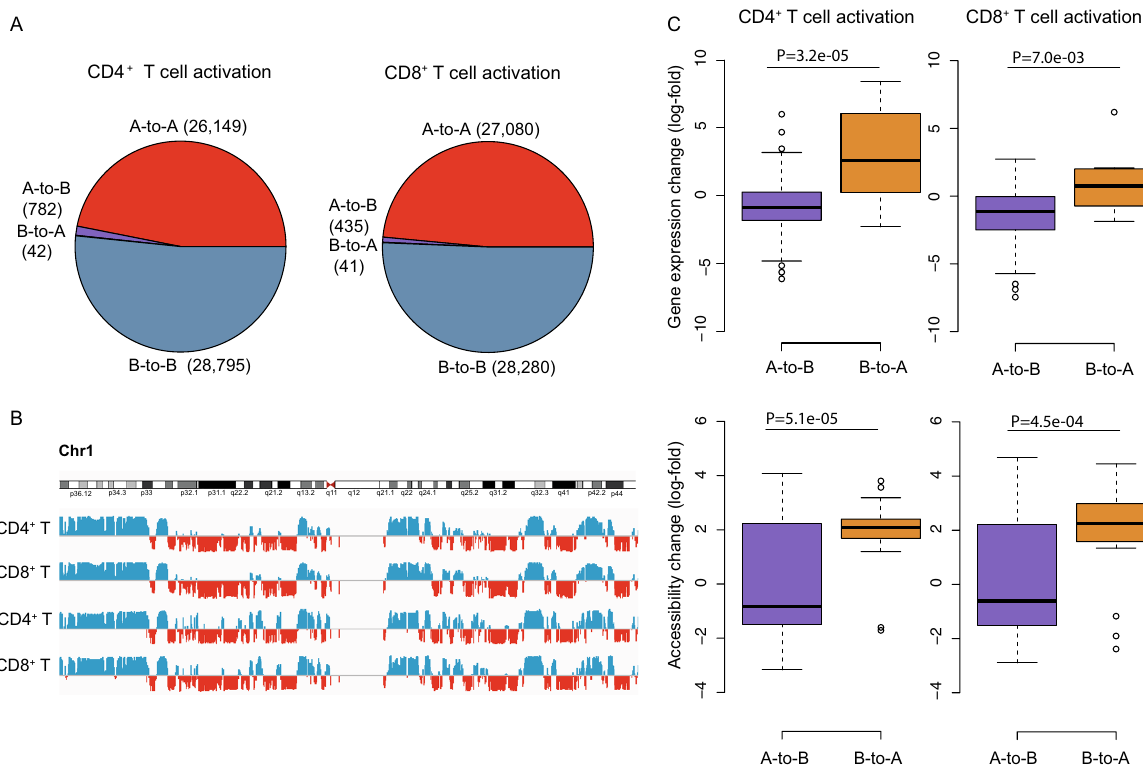
Figure 7. Chromosome A/B compartments are not substantially altered by T cell activation. ( A ) Pie charts showing the distribution of chromatin regions in the four different group of compartment changes: stable (A to A, B to B) or flipping (A to B and B to A). This was defined by pairwise comparison between activated and resting T cells. ( B ) PCA (principal component analysis) scores in resting and activated T cells along chromosome 1 representing the stability of the A/B compartments. PCA scores were calculated as described in “Methods”. ( C ) Boxplots showing the distribution of chromatin accessibility and gene expression at regions that exhibit A/B compartment shifts upon T cell activation. Shown are the median (central horizontal line), interquartile range (boxes), values of the upper and lower quartiles (whiskers), outliers beyond 1.5 IQR (circles). Statistics were determined with the unpaired Wilcoxon